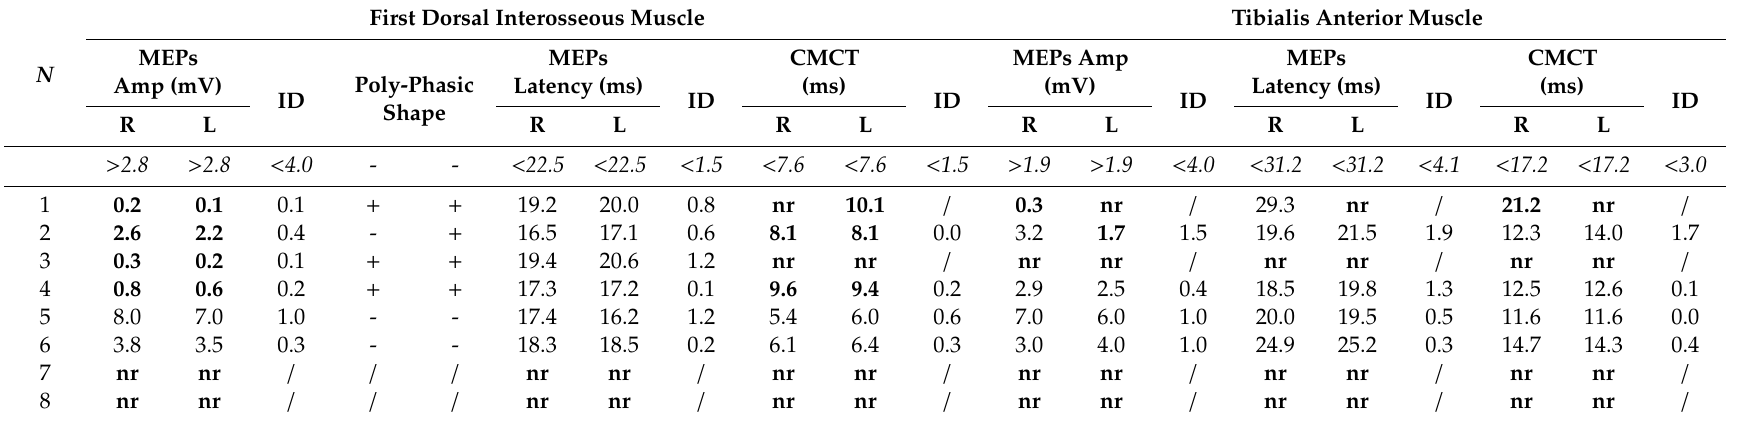
Table 2. Motor evoked potentials of MPS